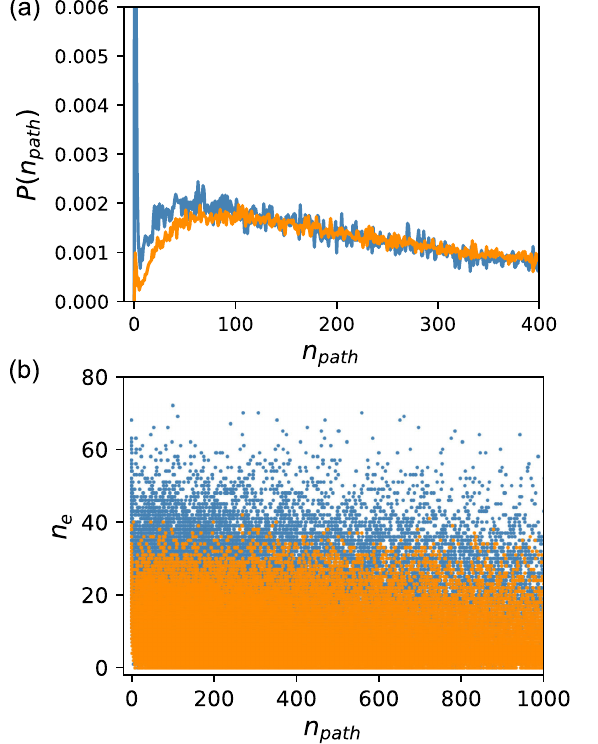
Fig 8. Number of paths n path starting from the input node and reaching the output node without passing the same . The data node twice. Orange indicates ES, and blue indicates random sampling. (a) Probability distribution of n path for n path � 400 are shown. The probability of GRNs with only one path reached 4% for random sampling. (b) Scatter and the number of essential edges n . The data for n � 1000 are shown. The data for f 2 [0.99, 1.0] are plot of n path e path shown for random sampling whereas the data for f 2 [0.99, 0.991) are shown for ES.